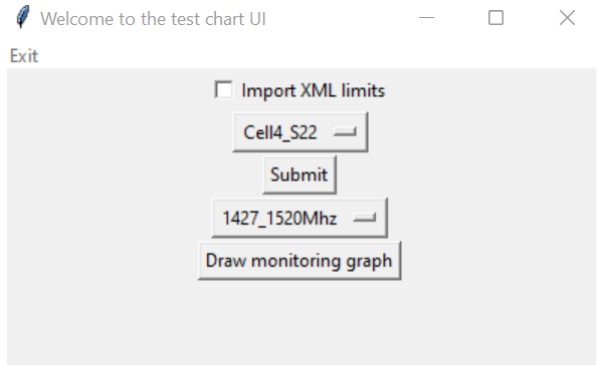
Figure 7. Graphical user interface (2).